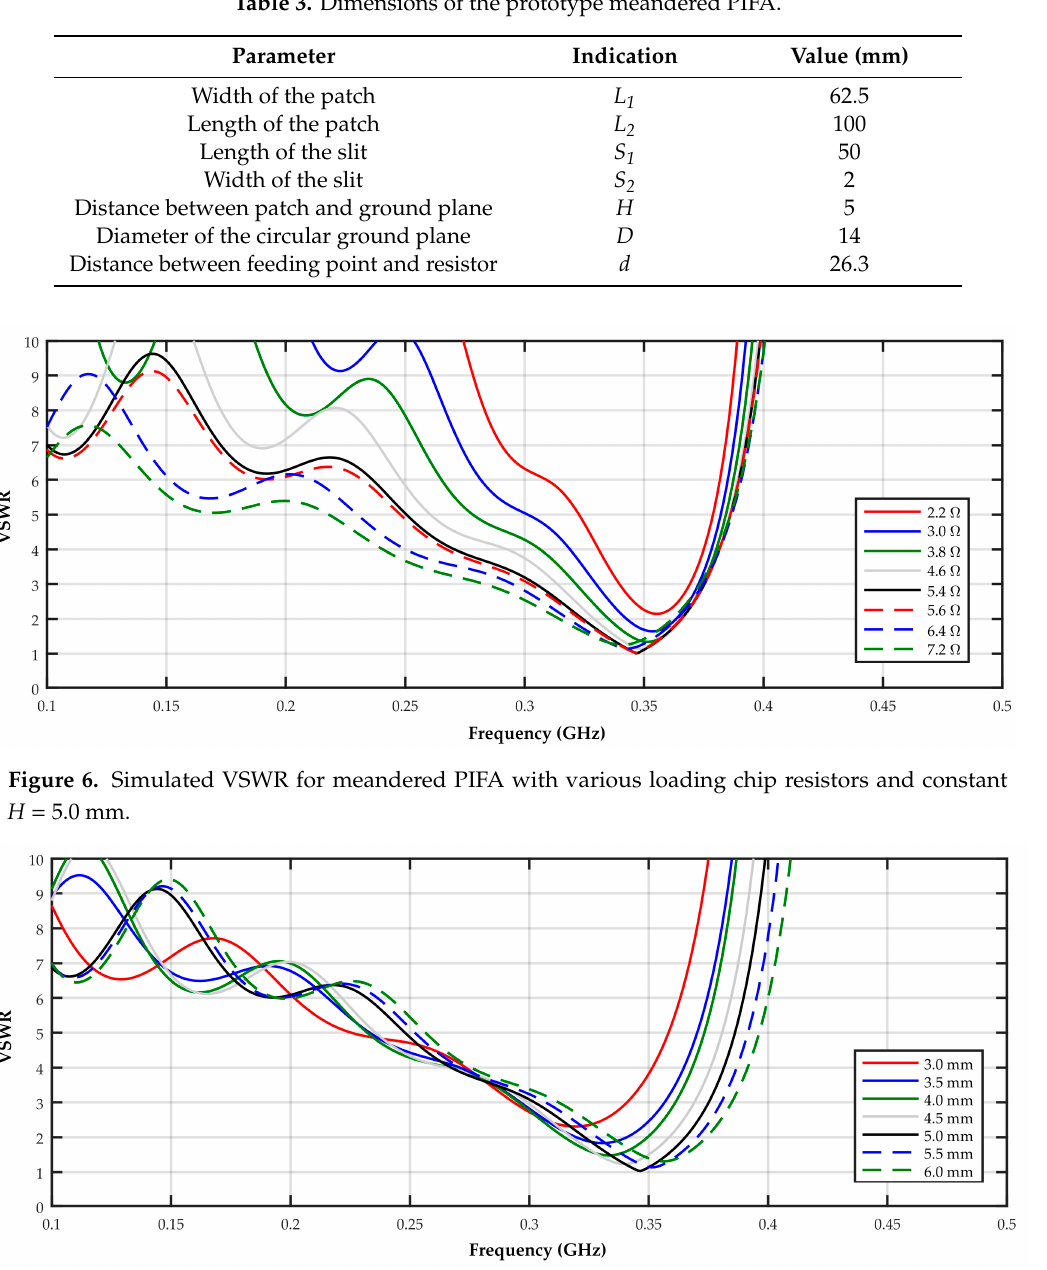
Figure 7. Simulated VSWR for prototype meandered PIFA with various distances H between patch and ground plane and with the same loading chip resistor with resistance R = 5.4 Ω .